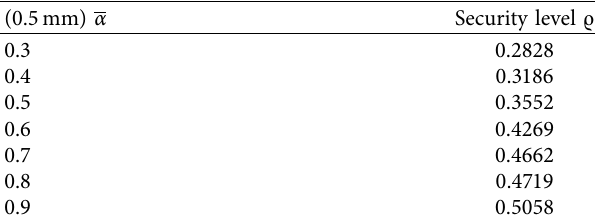
Table 1: The minimum security level under different α .